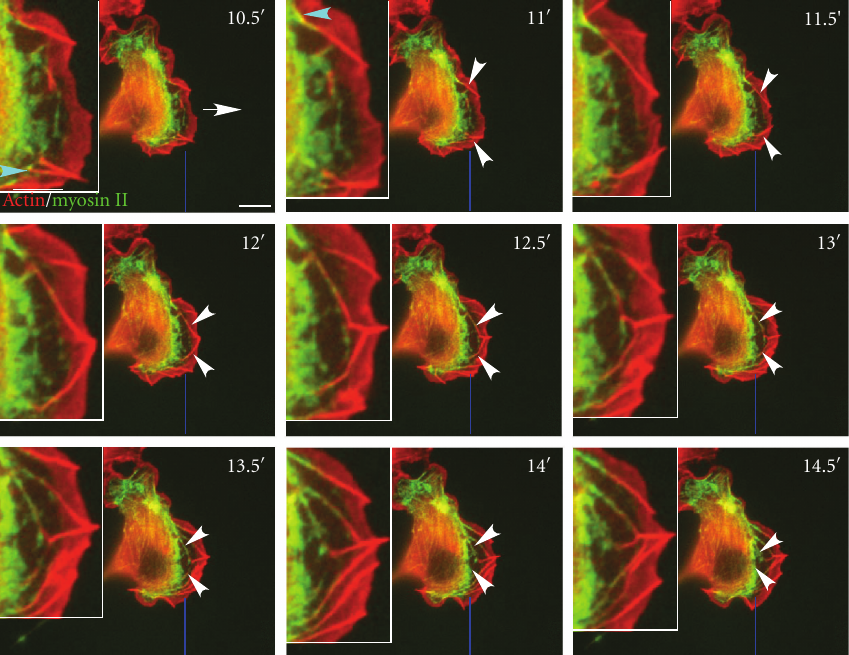
Figure 6: Lateral filopodia and myosin II play important roles in actin-arc formation. (a) Live cell time-lapse of B16F1 cell cotransfected with mCherry-actin and myosin II-GFP. The white arrow shows the direction of cell migration. Turquoise arrowheads show the association of myosin II to filopodia. White arrowheads show the fusion of two converging lateral filopodia. The thick blue line indicates the original position of the leading edge at 0 (cid:3) . The insets show a zoomed in view of the same field. Myosin II associated with the proximal ends of lateral filopodia which subsequently merged and moved into the cell body. The entire movie can be found in Supplementary Data, Movie 4. Scale Bar 10 μ